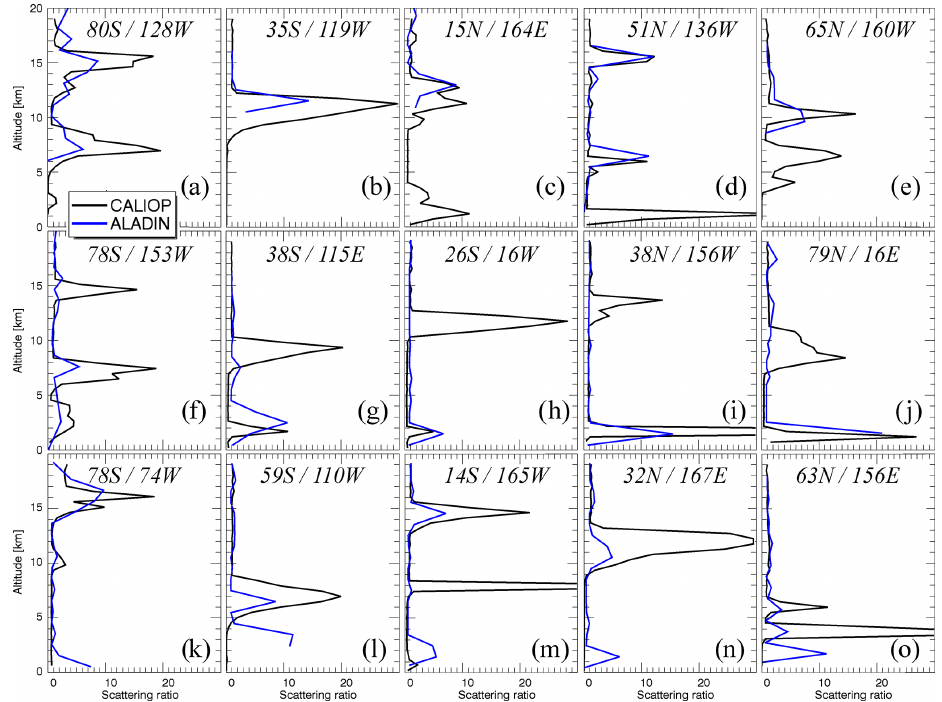
Figure 7. Pseudo-instantaneous comparisons of collocated ALADIN L2A SR profiles and CALIOP SR profiles averaged over 67km along the track: (a, f, k) 90–60 ◦ S, (b, g, l) 60–30 ◦ S, (c, h, m) 30–30 ◦ N, (d, i, n) 30–60 ◦ N, and (e, j, o) 60–90 ◦ N. (a–e) Cases confirming ALADIN’s capability to detect high-level clouds, (f–j) cases showing the cases when ALADIN misses a high cloud detected by CALIOP, and (k–o) cases showing a low-level cloud detected by ALADIN and not detected by CALIOP in the presence of a higher thick cloud detected by both instruments.